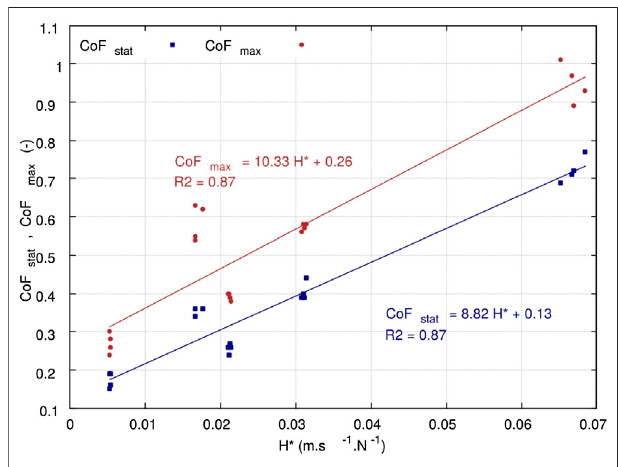
FIGURE 14 | Stribeck curve for HiTape ® over the pressure and speed ranges representative of double-membrane hot vacuum forming conditions.